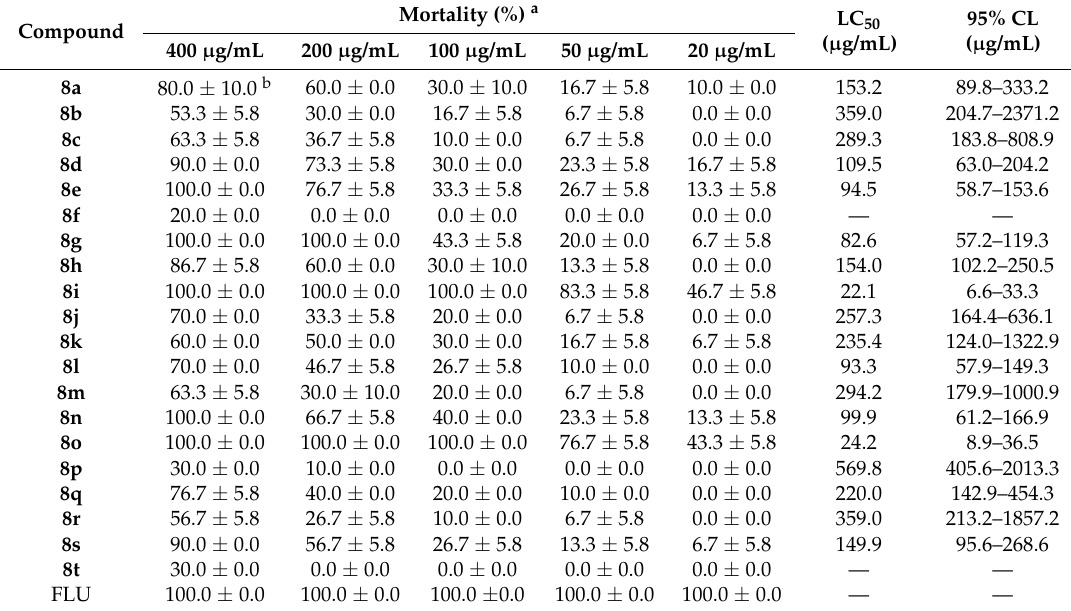
a Experimental size: 10 insects per group, three groups. b Each value represents the mean ± standard deviation of three replications; LC 50 = 50% lethal concentration; 95% CL = 95% confidence limit; “—” refers to “not